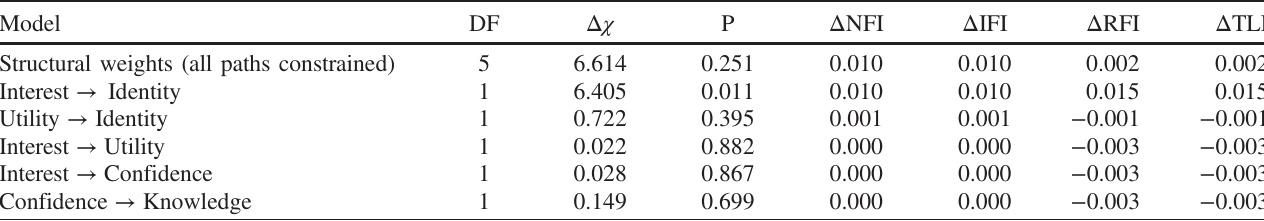
TABLE IV. Multigroup analysis for girls and boys for the model in Fig. 3.